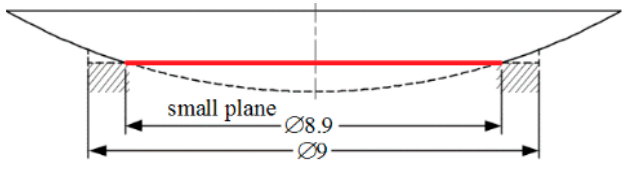
Figure 8. Eccentric distribution model of a single hole.